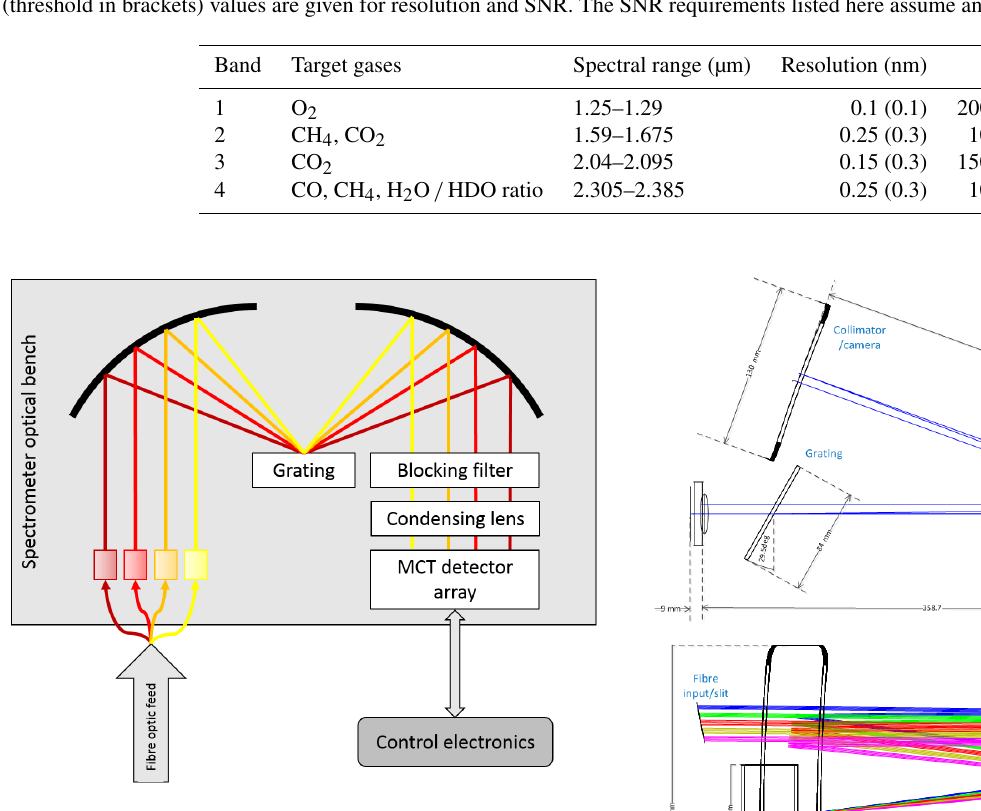
Figure 6. Block diagram showing a simple overview of the GHOST spectrometer optical layout.